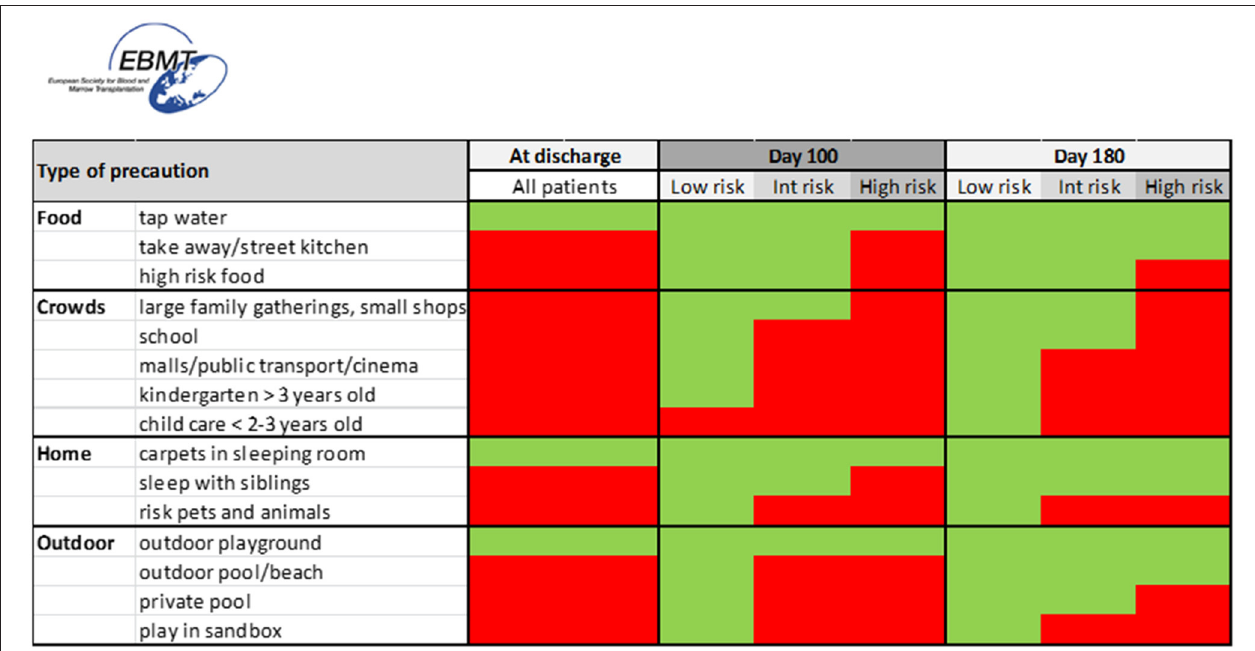
FIGURE 1 | Schematic algorithm for protective measures following discharge from allogeneic hematopoietic cell transplantation in childhood or adolescence. Red color indicates not recommended, green color indicates no restrictions. High risk foods: unpasteurized milk; undercooked egg; blue cheese; honey; raw and undercooked fish, meat and seafood; selected nuts; dried spices from uncontrolled shops/markets; unwashed or unpeeled fresh fruit, water from private wells. Nursery: 0–3 years. Kindergarten: 3–5/6 years. High risk pets: turtles (yersinia), shifting cat trays (toxoplasma), visit stables (aspergillus), acquire new pets. Private pool: if not at bacterial infection. Tap water: local outbreaks may moderate.